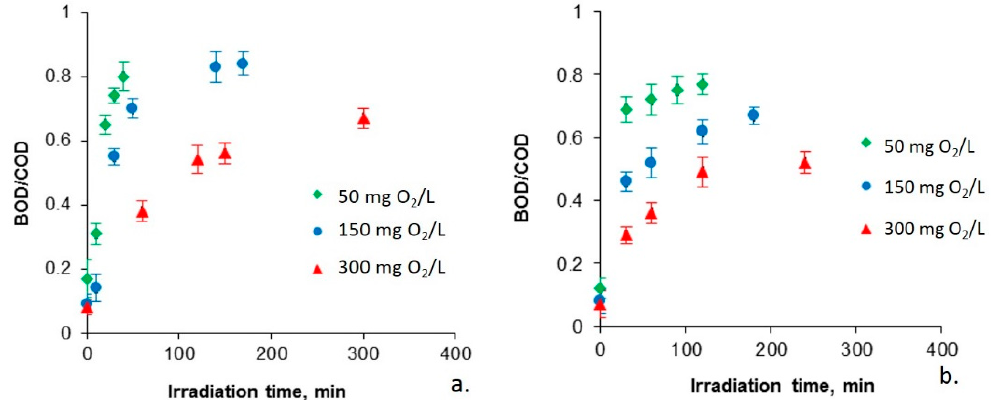
Figure 3. Biodegradability of chlorophenols: ( a ) 4-chlorophenol, ( b ) 2,4-dichlorophenol. Error bars represent the calculated standard deviation for the experimental data.